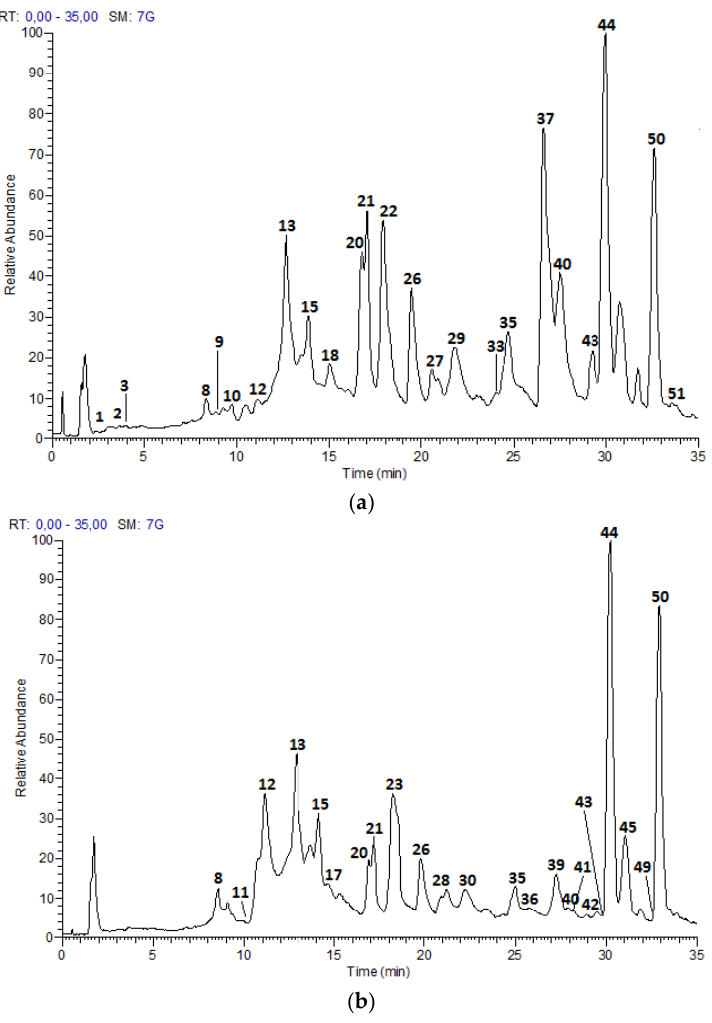
Figure 1. HPLC Chromatograms of M. domestica extracts: ( a ) Anna skins ( b ) Anna flesh, in a Hypersil Gold AQ RP-C18 column (200 mm × 2.1 mm × 1.9 µm) using a LTQ Orbitrap XL Mass spectrometer (Thermo Scientific™, Walthman, MA, USA) in a mass range from 100 to 2000 amu.